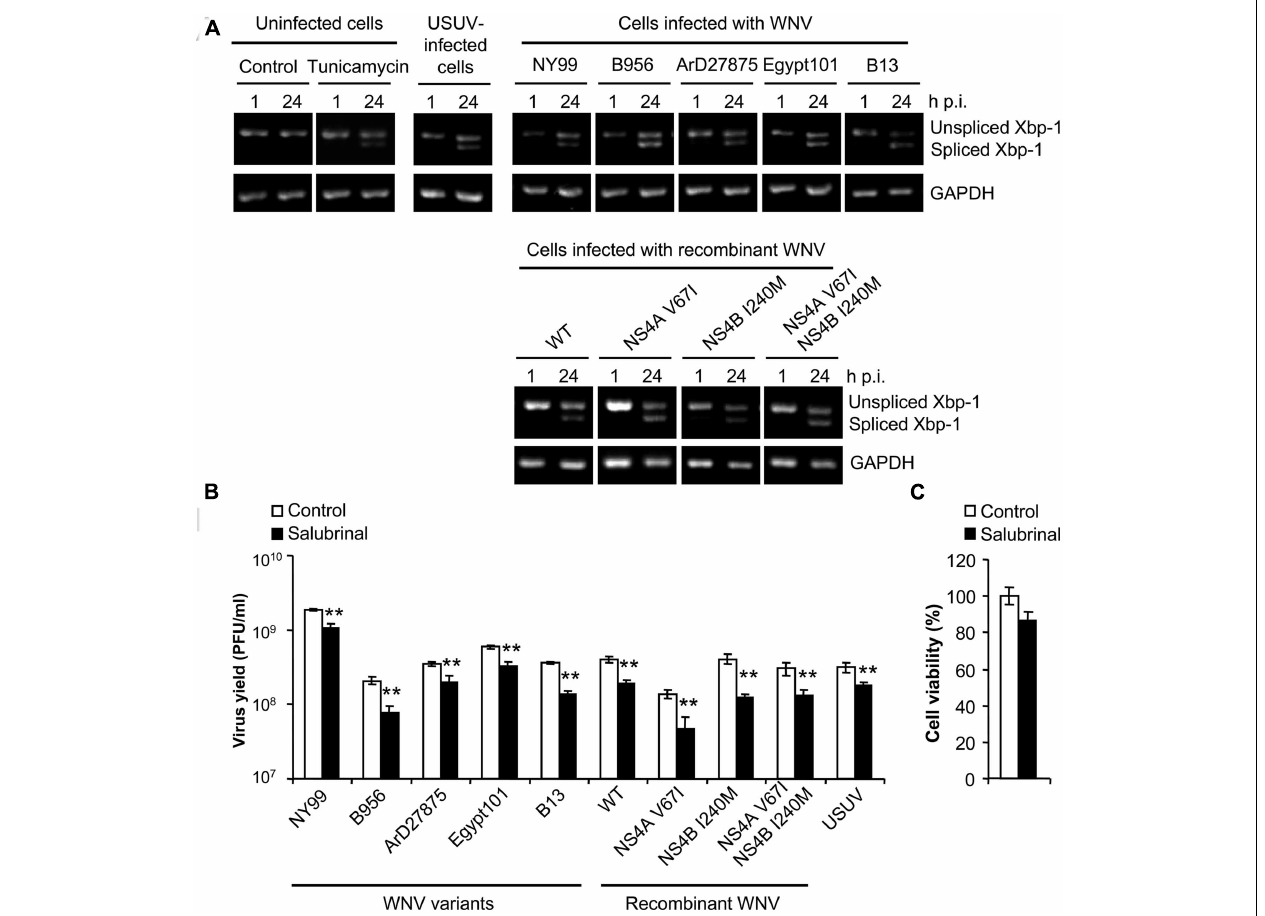
FIGURE 4 | Infection withWNV variants that differ in induction of autophagy results in similar UPR features. (A) Activation of the unfolded protein response (UPR) following infection withWNV or USUV assayed by detection of spliced Xbp-1 mRNA. RNA was extracted fromVero cells infected withWNV B956, ArD27875, Egypt101, NY99, B13, recombinant WNV recovered from infectious cDNA clone pFLWNV (WT) or its derivatives carrying amino acid substitutions NS4AV67I, NS4B I240M or NS4AV67I + NS4B I240M, and the presence of unspliced or spliced Xbp-1 mRNA was determined by RT-PCR. Cells treated with tunicamycin, or infected with USUV are included as a positive control of the activation of UPR. GAPDH mRNA